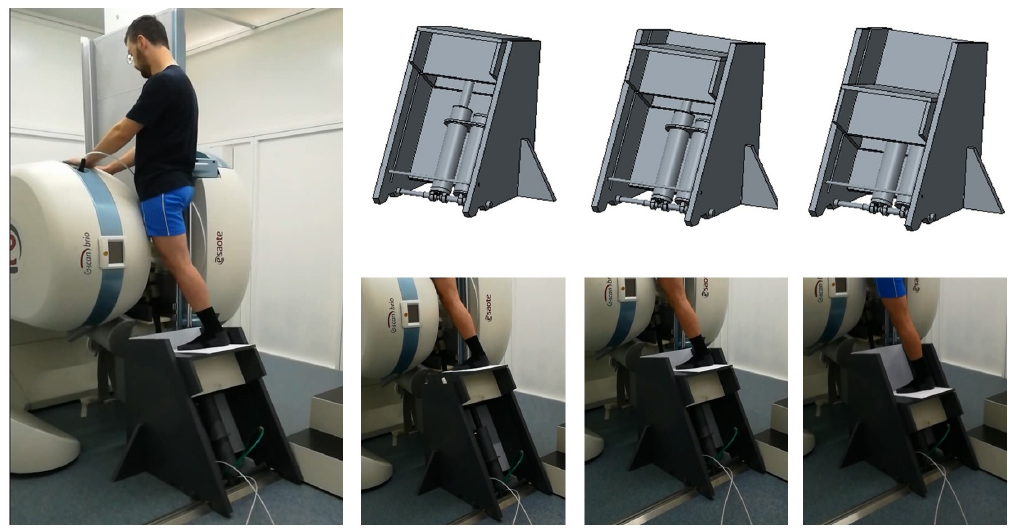
Figure 2. The MR-compatible rig used to guide the knee flexion.